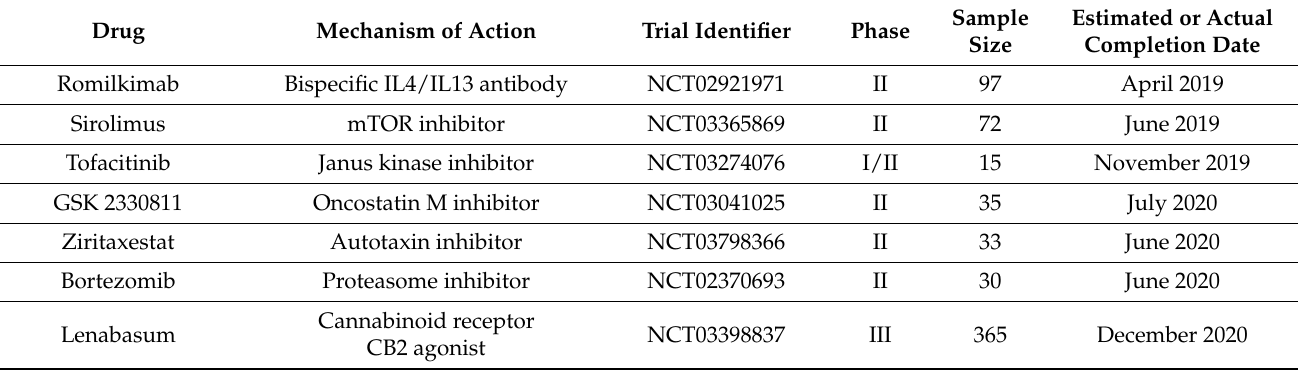
Table 3. Ongoing or recently completed pharmacological clinical trials in systemic